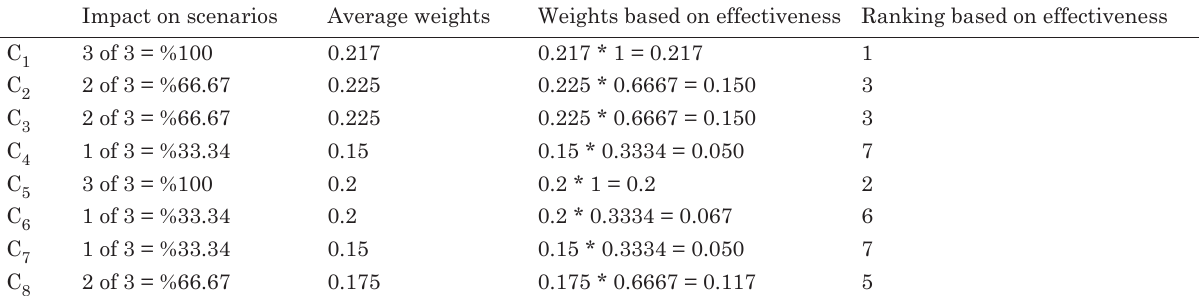
Table 16. investigation on effectiveness of criteria based on scenarios impact on scenarios